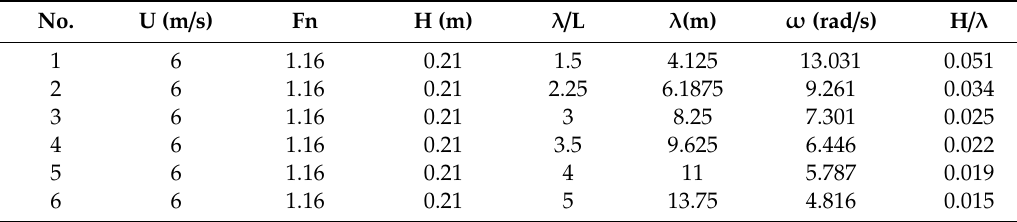
Table 2. Regular wave test matrix of the seakeeping test.